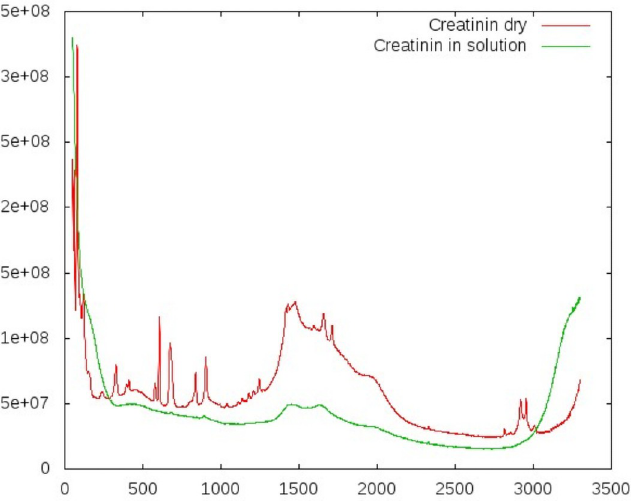
Fig 2. Comparing dry samples and samples in solution: Creatinine. All specific peaks vanish in solution for these substances. At around 1500 cm − 1 , the fluorescence background of the glass carrier is visible. Exposure time: 172 s, concentration: 10